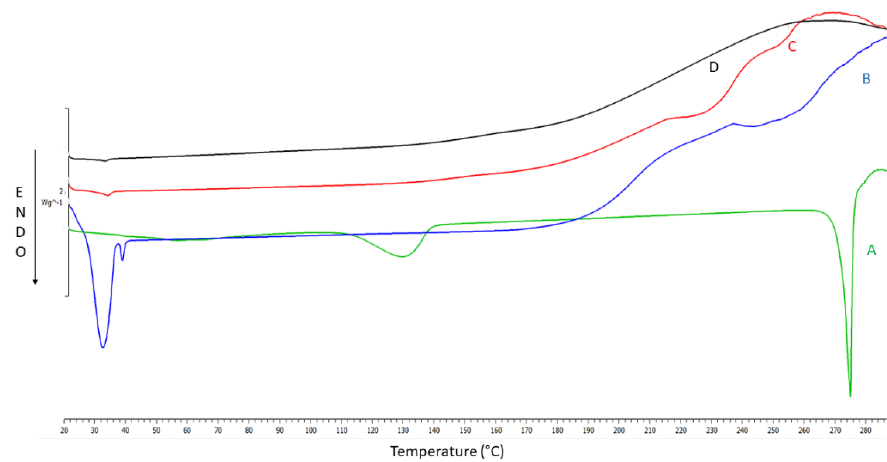
Figure 11. Differential scanning calorimetry (DSC) thermograms of diosmin ( A ), Softisan ® 100 ( B ), blank NLCs ( C ), and D-NLCs ( D ).